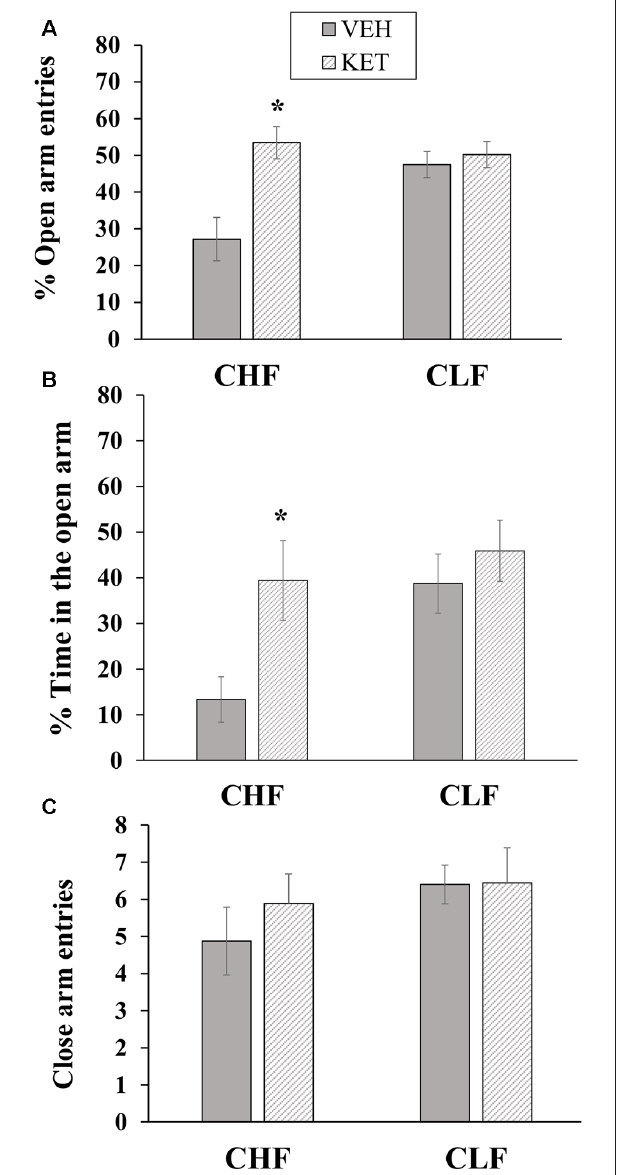
FIGURE 6 | Mean + SEM percentage of open arm entries (A) , percent time spent on the open arms (B) and closed arm entries (C) in the EPM in CHF and CLF animals that received ketanserin (KET) or vehicle (VEH) microinjections in the PL cortex. ∗ p < 0.05 KET vs. VEH among CHF animals.